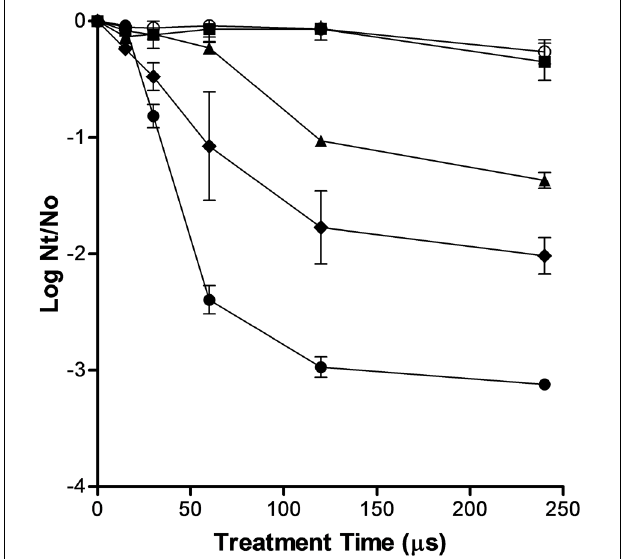
FIGURE 1 | Inactivation of Saccharomyces cerevisiae by pulsed electric fields (PEF) treatments of different electric field strengths. 5 kV/cm ( (cid:13) ), 10 kV/cm ( (cid:4) ), 15 kV/cm ( (cid:78) ), 20 kV/cm ( (cid:7) ), 25 kV/cm ( • ). Inactivation data was expressed as the ratio between the initial number of survivors (N o ) and the number of survivors after different treatment times (N t